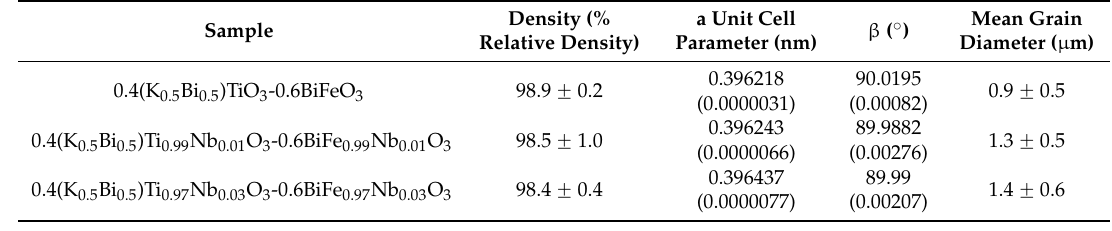
Table 1. Physical properties of (K 0.5 Bi 0.5 )Ti 1– x Nb x O 3 -0.6 BiFe 1– x Nb x O 3 ceramics.